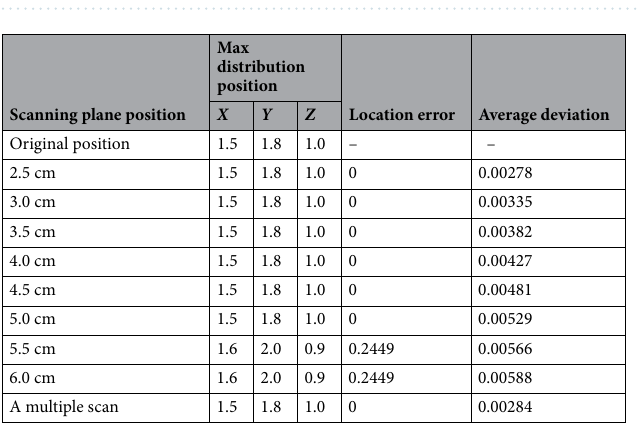
Table 1. Location error of the inverse distribution with different Z